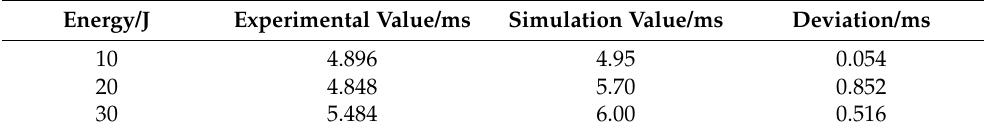
Table 4. Comparison of contact time in experiment and simulation under different impact energies.